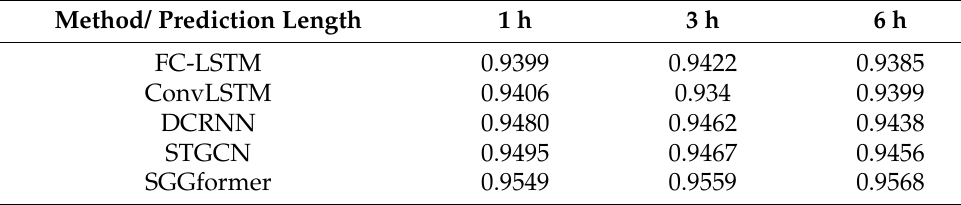
Table 3. Results of comparison with the baselines on quadratic-weighted kappa